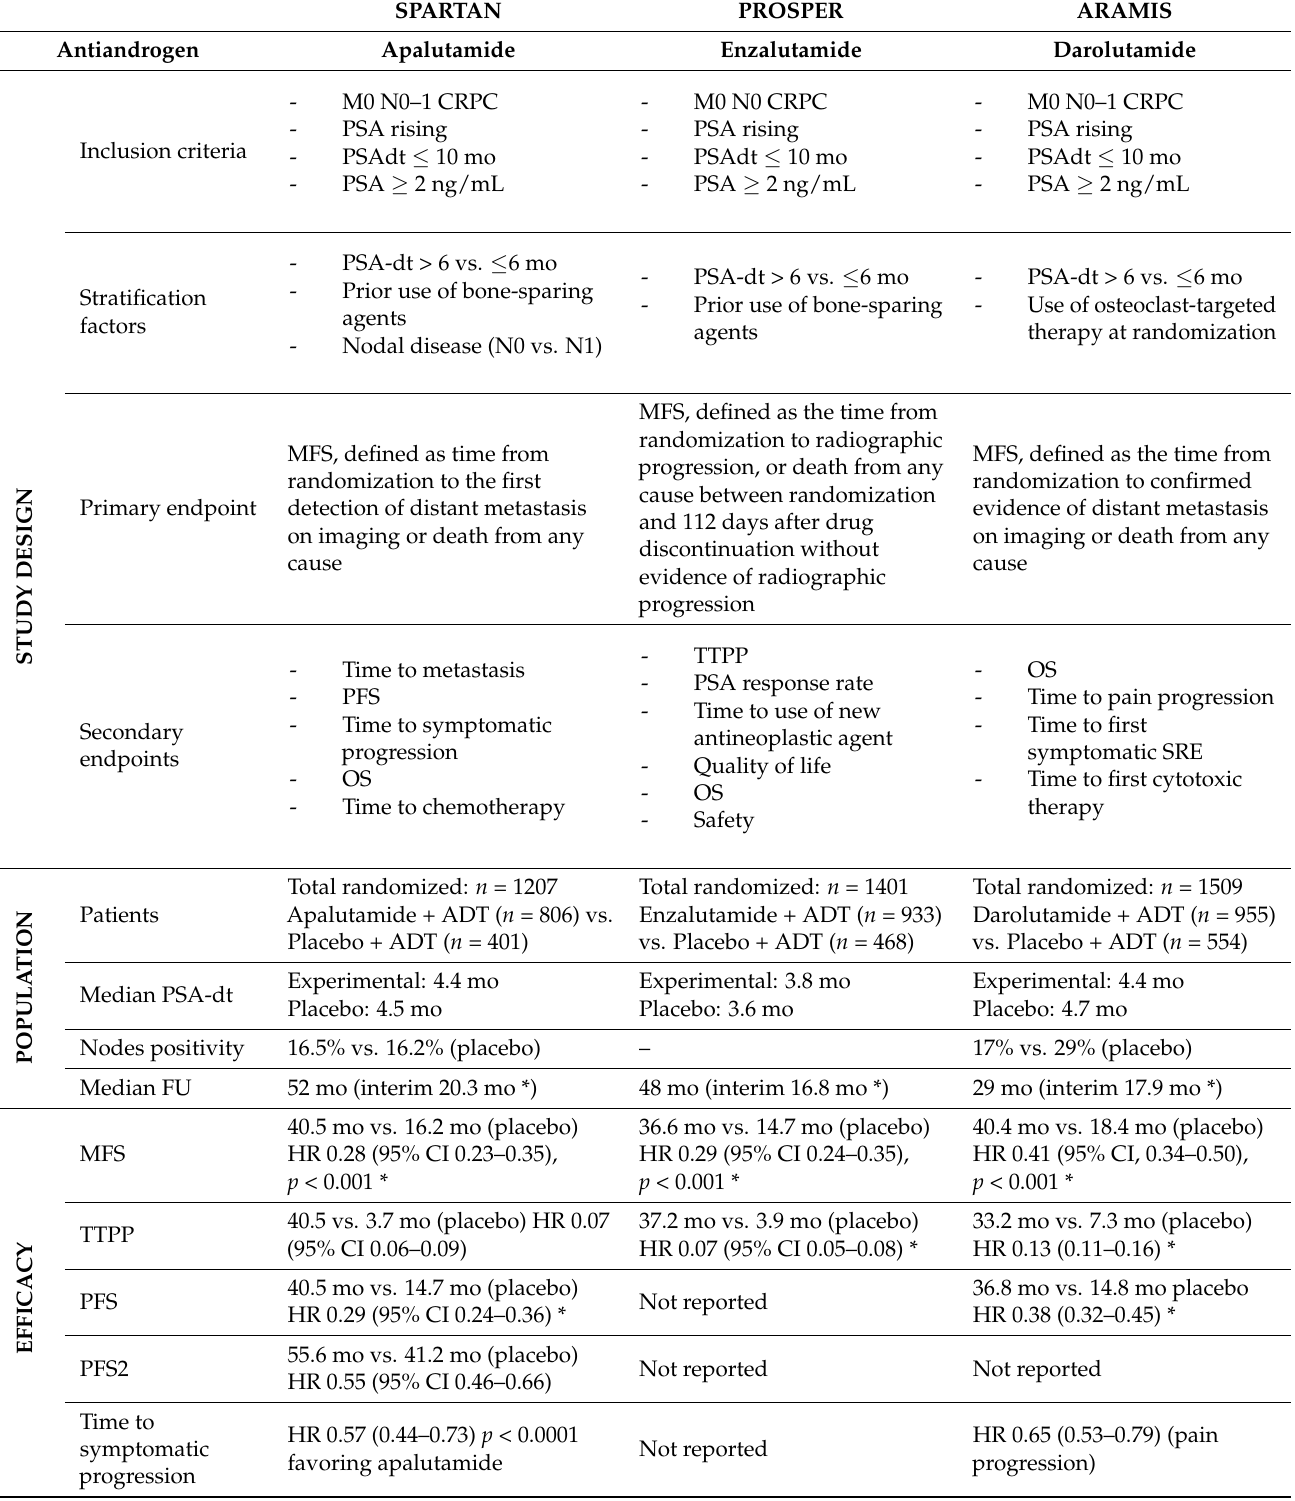
Table 1. Phase 3 randomized clinical trials in